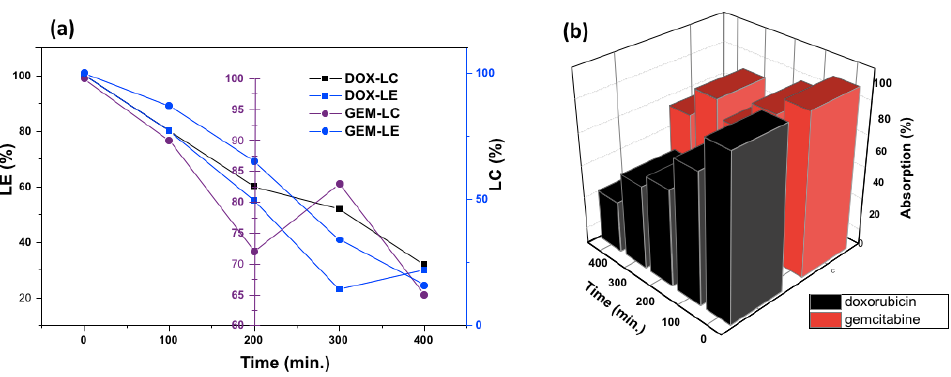
Figure 9. ( a ) Loading capacity (LC), loading efficiency (LE), and ( b ) relative absorption of gemcitabine and doxorubicin PEGylated ZnO-NPs.